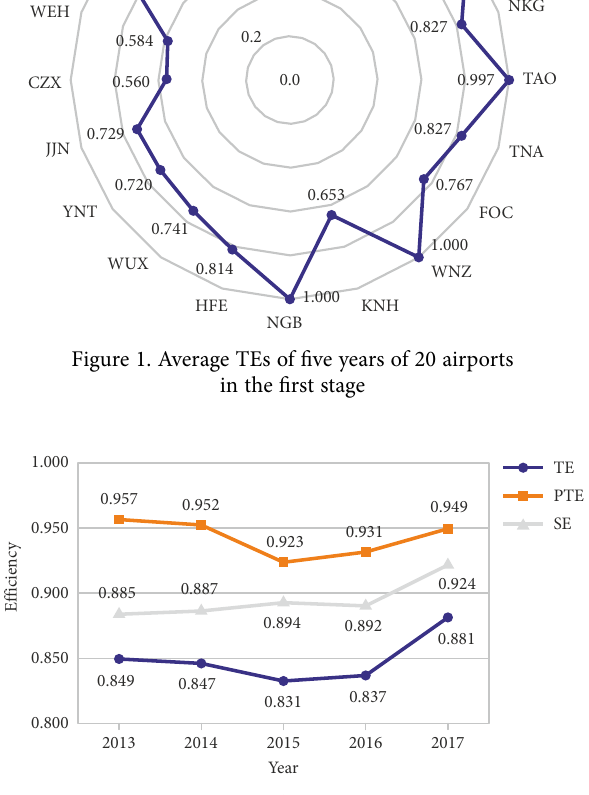
Figure 2. Average efficiencies of 20 airports from 2013 to 2017 in the